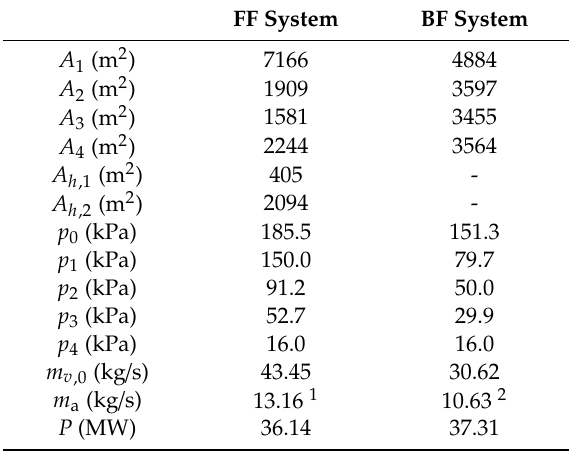
Figure 7. Variations of power outputs of the FF and BF systems with the maximum sugar juice flow rate. Table 1. Simulation results at optimum operating conditions for the FF and BF systems that process 125 kg/s of inlet sugar juice.